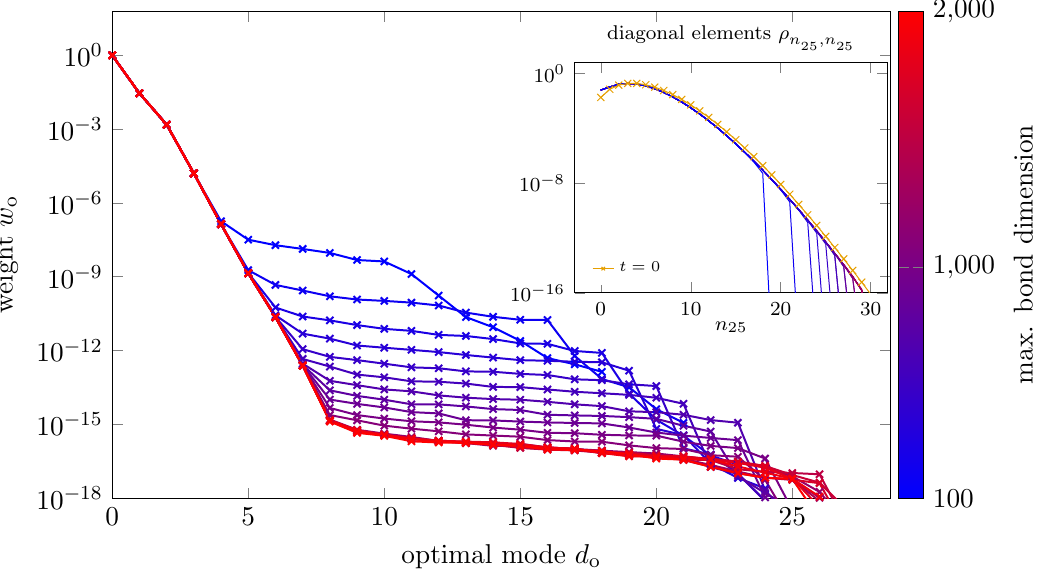
Figure 6: Weight w of optimal modes d as a function of the maximal bond dimen- o o sion at the auxiliary bond γ using the projected purification. Data is extracted from 25 the 1RDM ρ at the center site ( j = 25) in the calculated ground state of the half- n , n (cid:48) 25 25 filled Holstein model with L = 51 sites and N = 25 fermions, ω/ t = 1.0, γ/ t = 2.0. The inset shows the diagonal elements ρ indicating the immediate effect of n , n 25 25 truncations. For comparison, the phonon-excitation probabilities obtained for t = 0 are overlayed, indicated by yellow